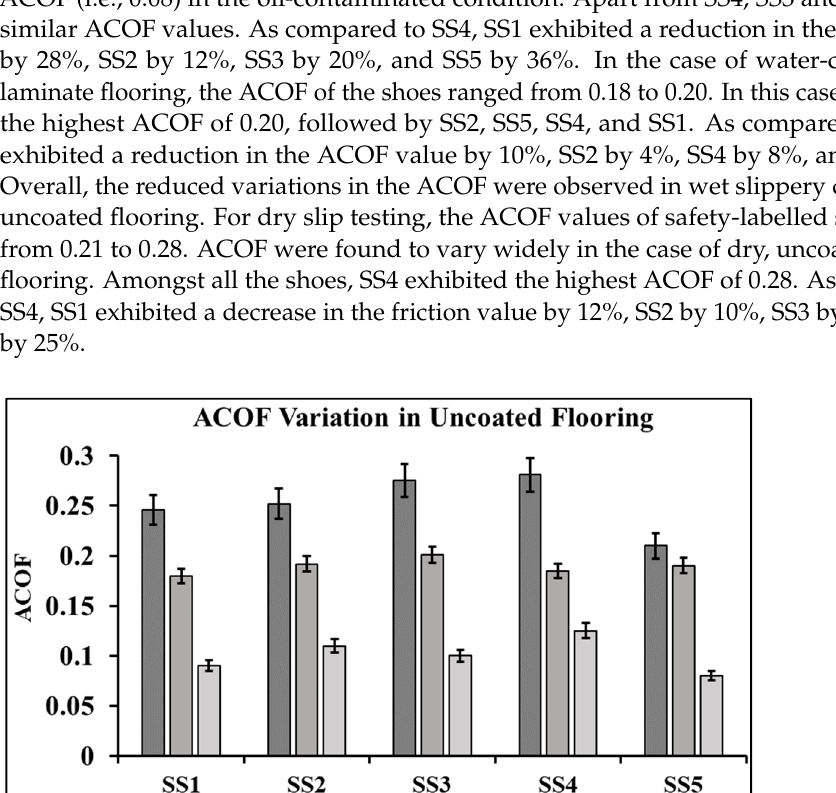
Figure 3. Biofidelic and portable whole-shoe robotic slip testing device.